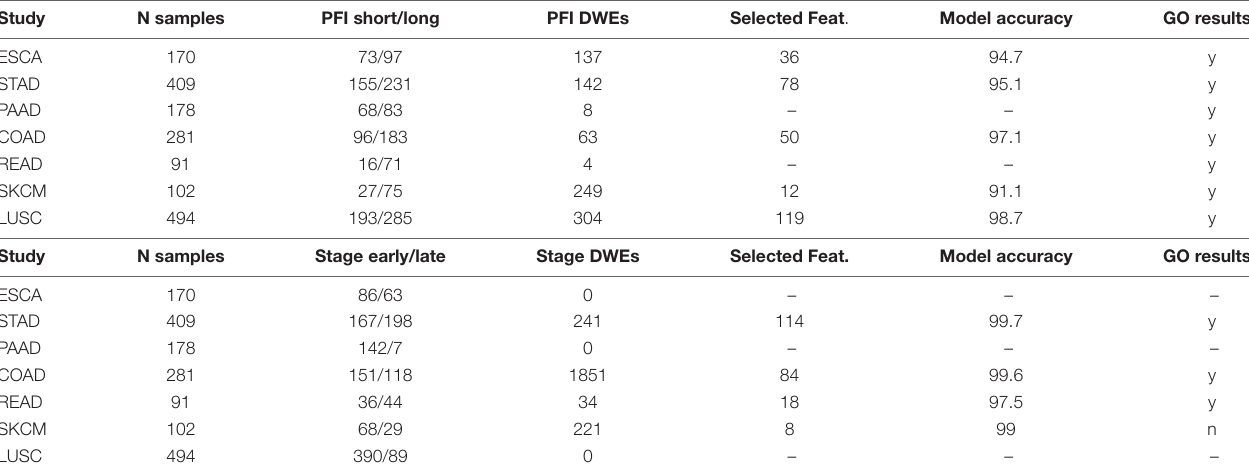
TABLE 1 | Counts of differentially weighted edges compared to the number of samples in each study. PFI short/long PFI DWEs Selected Feat